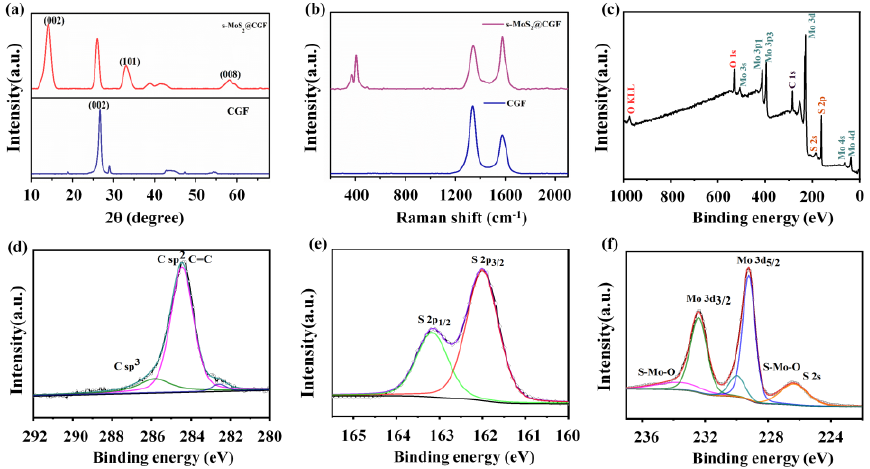
Figure 4. ( a ) XRD pattern; ( b ) Raman spectra of the prepared CGF and MoS 2 @CGF composite; ( c ) total XPS spectrum of MoS 2 @CGF; XPS spectra of MoS 2 @CGF in ( d ) C 1s, ( e ) S 2p, and ( f ) Mo 3d, respectively.